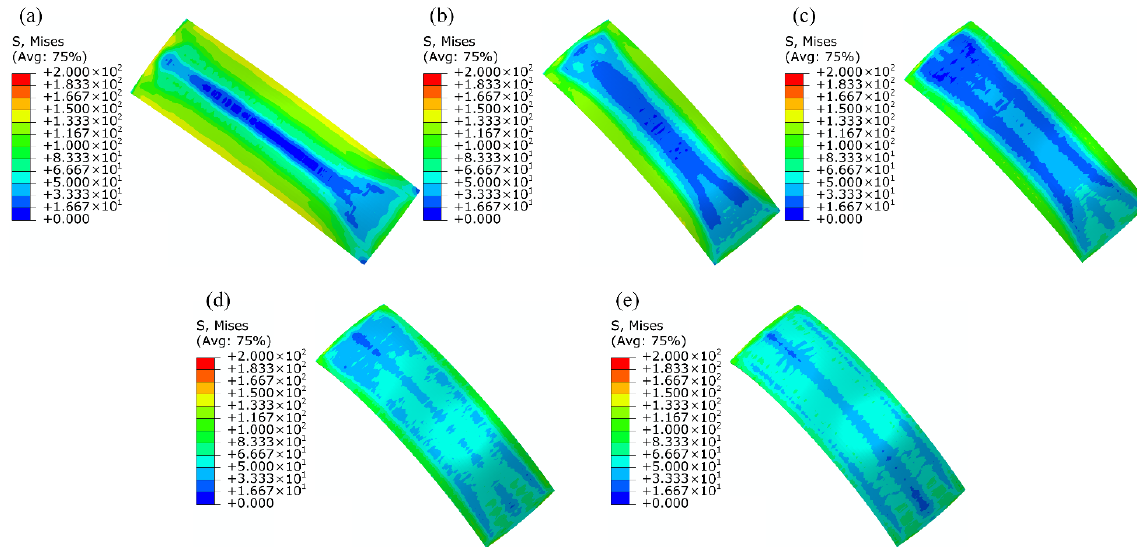
Figure 10. Von Mises stress distribution with different rolling reductions of the sheet metals: ( a ) ∆ h = 0.04 mm; ( b ) ∆ h = 0.06